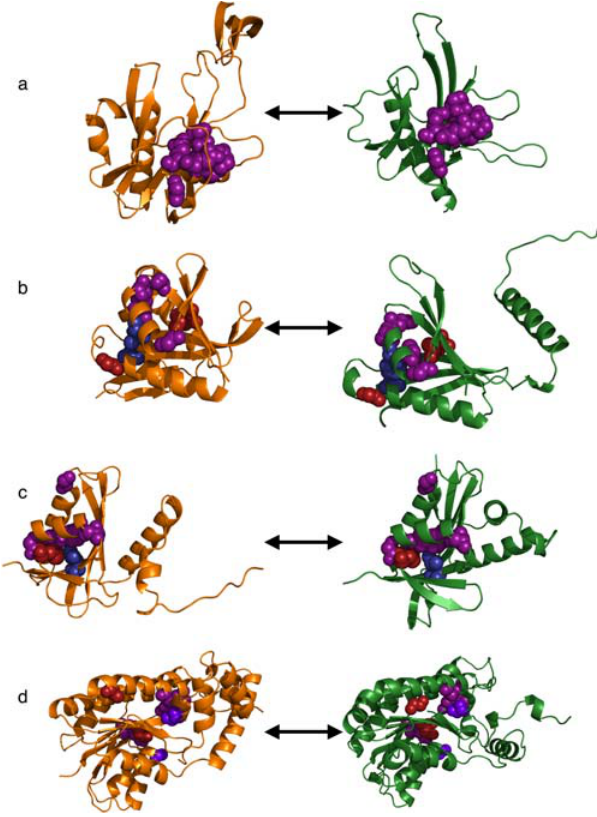
Figure 7. Examples of ETA Predictions. Reciprocal matches contributing to three novel ETA function predictions, with the query in orange and the target in green, and template/match residues using the scheme in Figure 5. 7a, query 1jrk, chain A, vs. target 1vhz, chain B; 7b, 1wwz, chain B, vs. 1y9w, chain A; 7c, 2fl4, chain A, vs. 1wwz, chain B; 7d, 1xkq, chain A, vs. 1jtv, chain